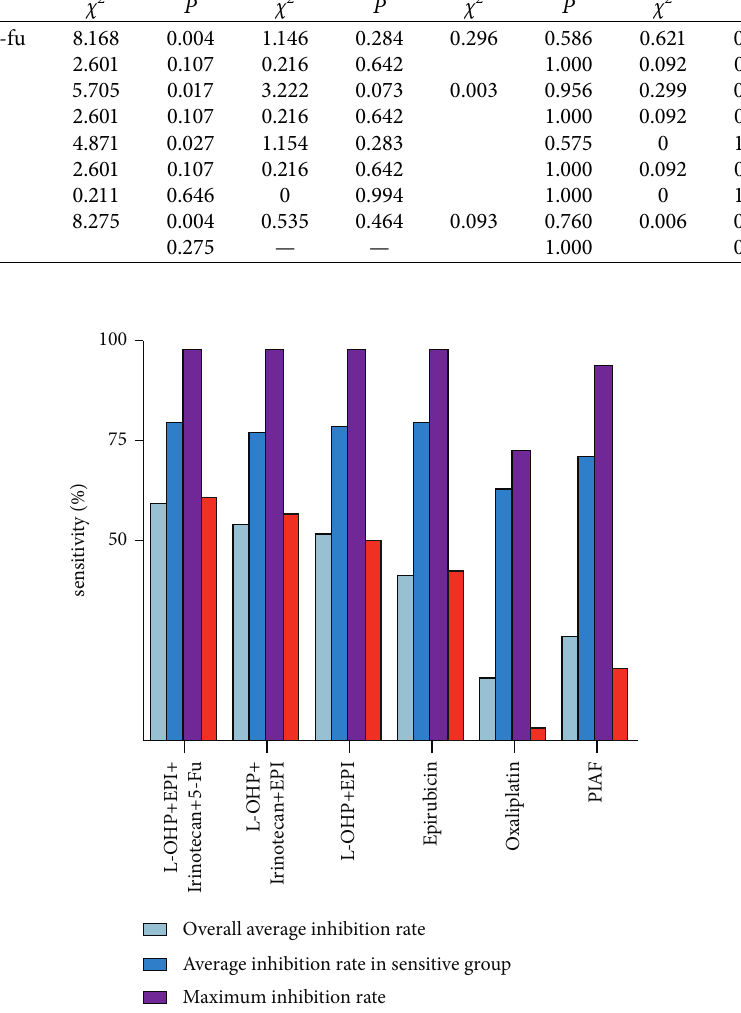
Figure 4: Comparison between medication regimens containing oxaliplatin and epirubicin with single